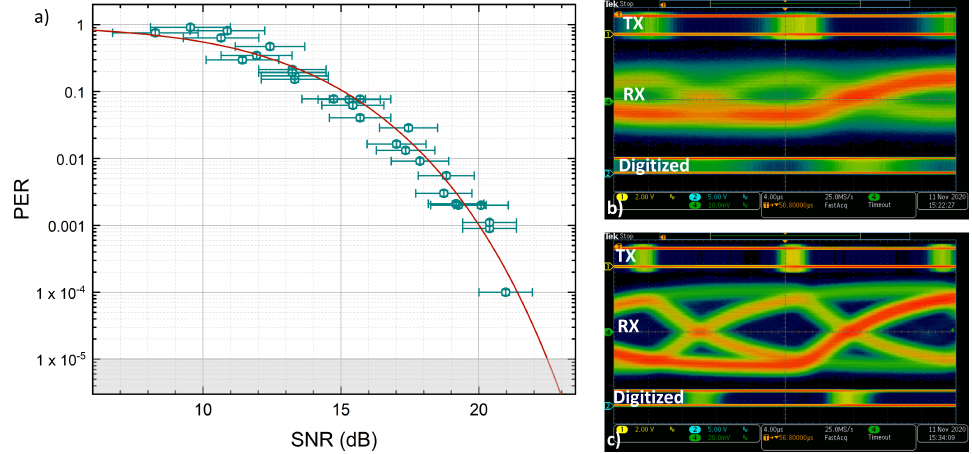
Figure 4. ( a ) Example of measured PER as a function of SNR on the received amplitude. Green circles correspond to experimental data, with horizontal error bars showing the uncertainty in the amplitude measurement. The vertical error bars are due to the variance on the number of wrong packets on consecutive measurements and are smaller than the symbol size. The red line is the best fit curve by the model given in the text. The shaded area represents the error-free region (higher limit) given by the maximum number of packets used in the tests. ( b , c ) Heat maps showing eye-diagrams for PER > 0.1 with SNR = 11 dB ( b ), and error-free communication achieved with SNR = 22 dB ( c ). Three traces are shown: TX, RX, and the (digitized) signal after comparator. The horizontal scale is 4 µ s. The acquisition is self-triggered on the RX signal, so that the horizontal spread of the digitized signal corresponds to a jitter of 1–4 µ s in the reconstructed VLC digital signal, depending on the SNR